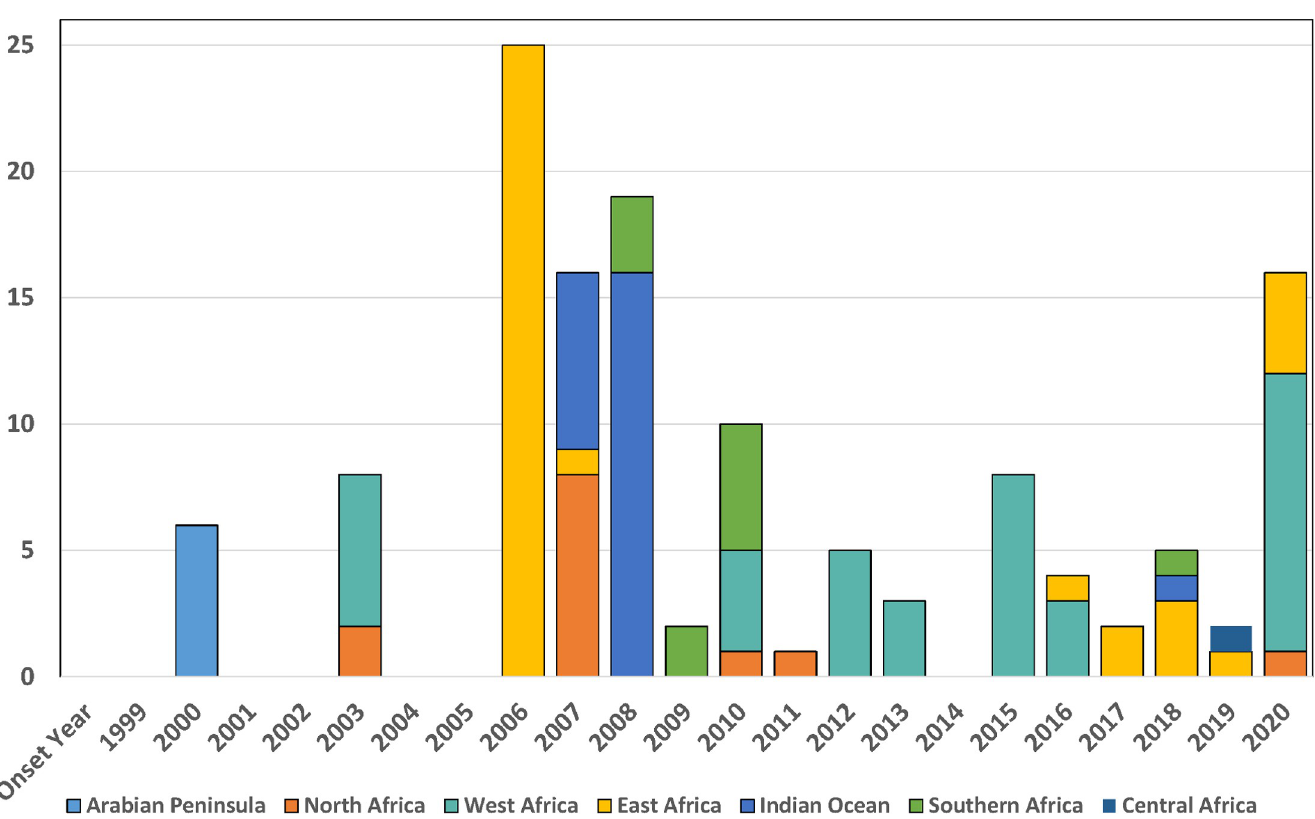
Fig 5. Acute human RVF events per year during 1999–2021, by geographic regions across Africa, the Indian Ocean, and the Arabian Peninsula.